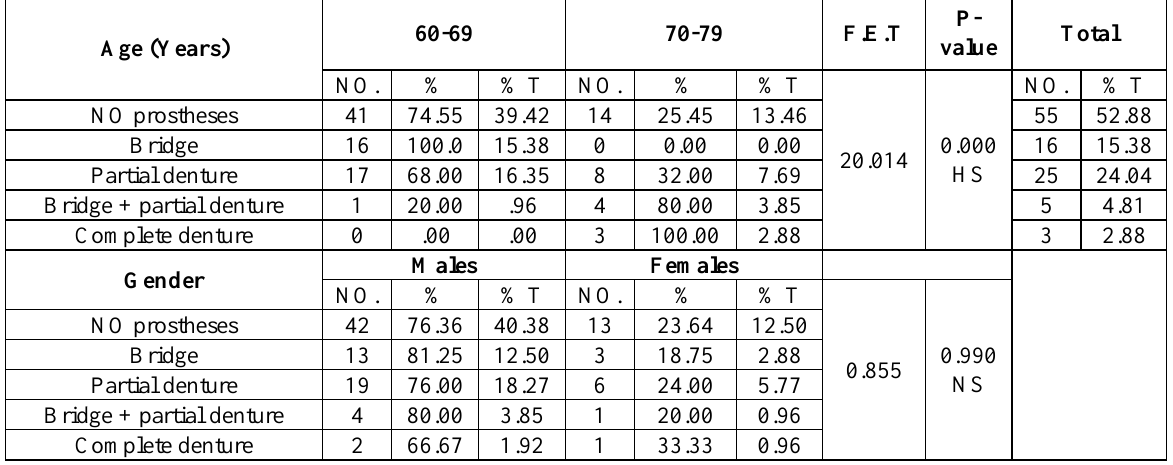
Table 1: Distribution of prosthetic status in upper arch by total and in age and gender. Age (Years)